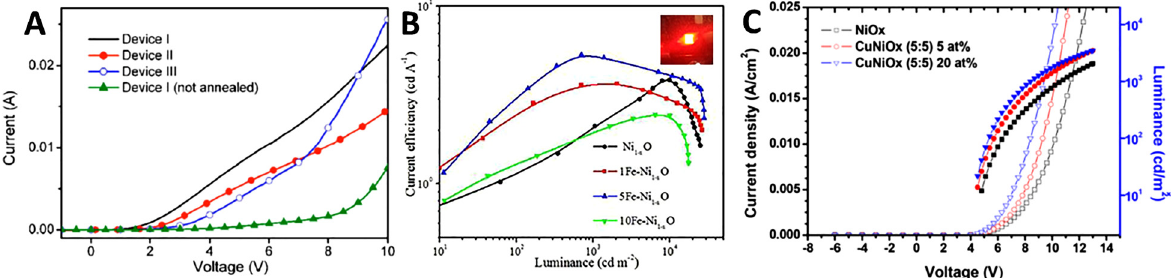
Figure 4: (A) I – V curvesfrom the different heterojunction devices,reprintedfrom [53]with permissionof AIP publishing. (B) Current ef fi ciency versus luminance of the Q-LEDs. The inset in (B) shows a digital photograph of the c-based Q-LED under a 5 V applied voltage. Reprinted from Ref. [37] Copyright 2020, with permission from Elsevier. (C) Current density – voltage – luminance curves of the hybrid LEDs (Hy-LEDs) – reprinted with permission from Ref. [47] Copyright 2018 American Chemical